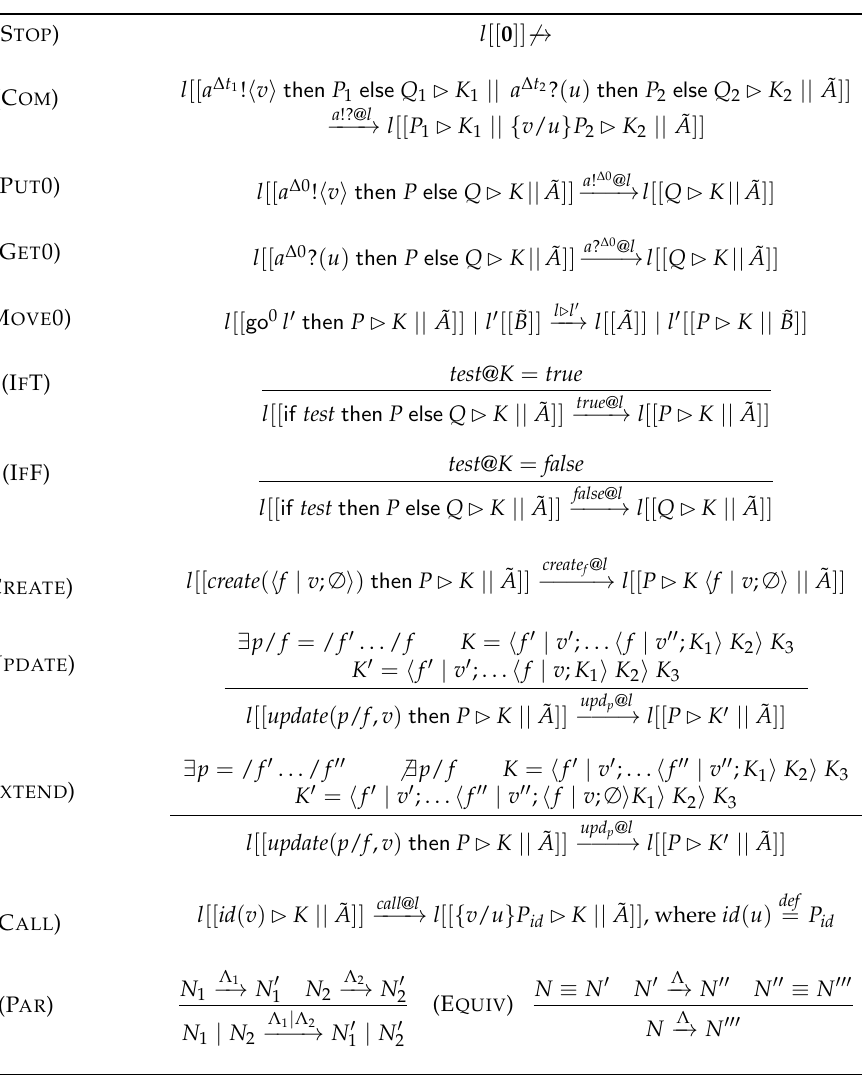
Table 2. Operational Semantics for our Multi-Agent